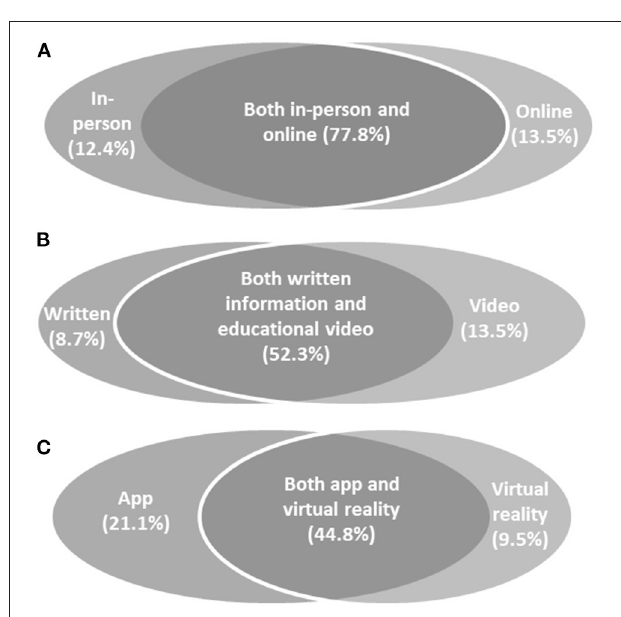
FIGURE 2 | Preferences for future participation: results indicated that the majority of respondents were interested in (A) continuing with both in-person and online dance classes, (B) receiving educational resources to optimise their dance practise, and (C) trying new modes of dance participation such as apps and virtual